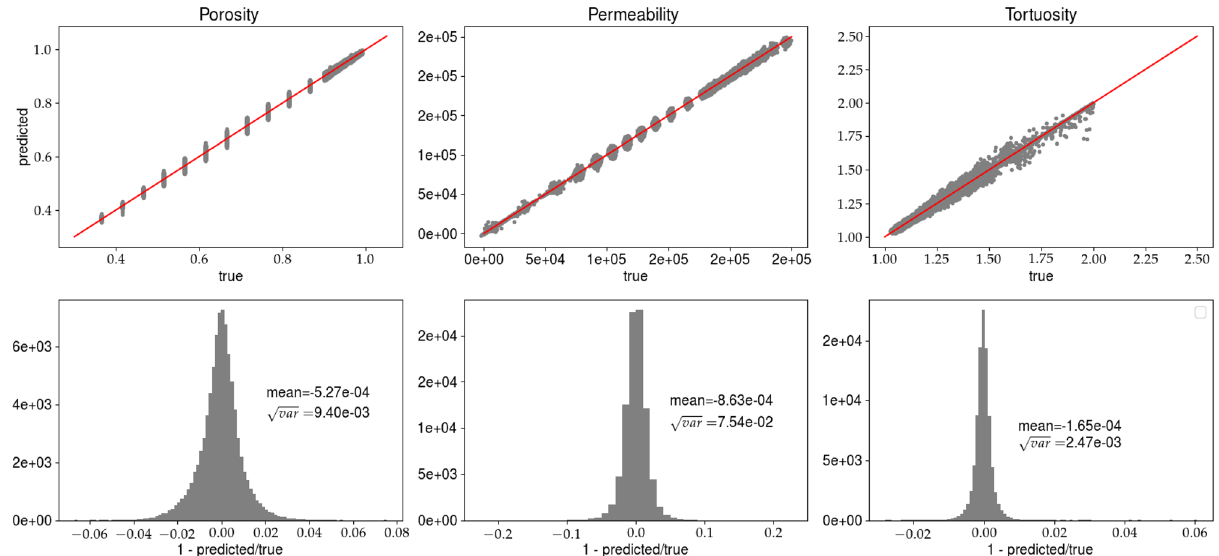
Figure 5. Predictions of the porosity, permeability, and tortuosity by the CNN versus ‘true‘ data (upper row). In the bottom row, the histograms of R , see Eq. (11), are plotted. The results are obtained for analysis (A) and the training data set. Solid line, in the top row, represents predicted